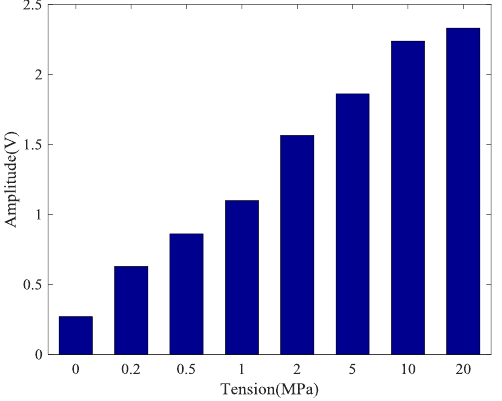
Figure 8. Mean of the magnitudes of the focused signals based on time reversal.